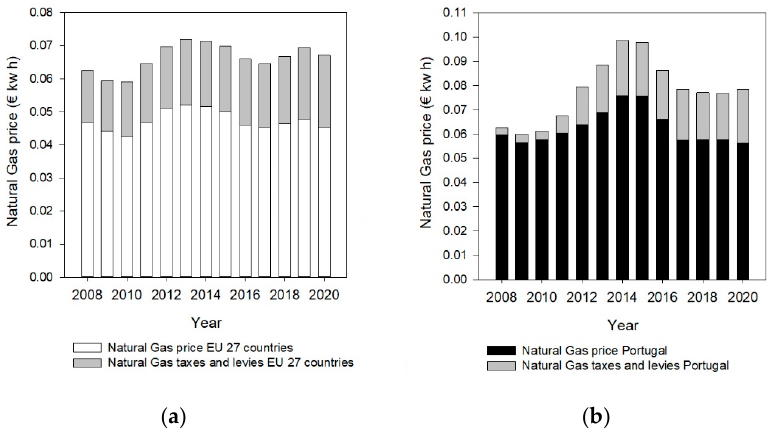
Figure 10. ( a ) Electricity prices for household consumers regarding: ( a ) EU-27 countries and ( b ) Por- tugal (data source [40]).